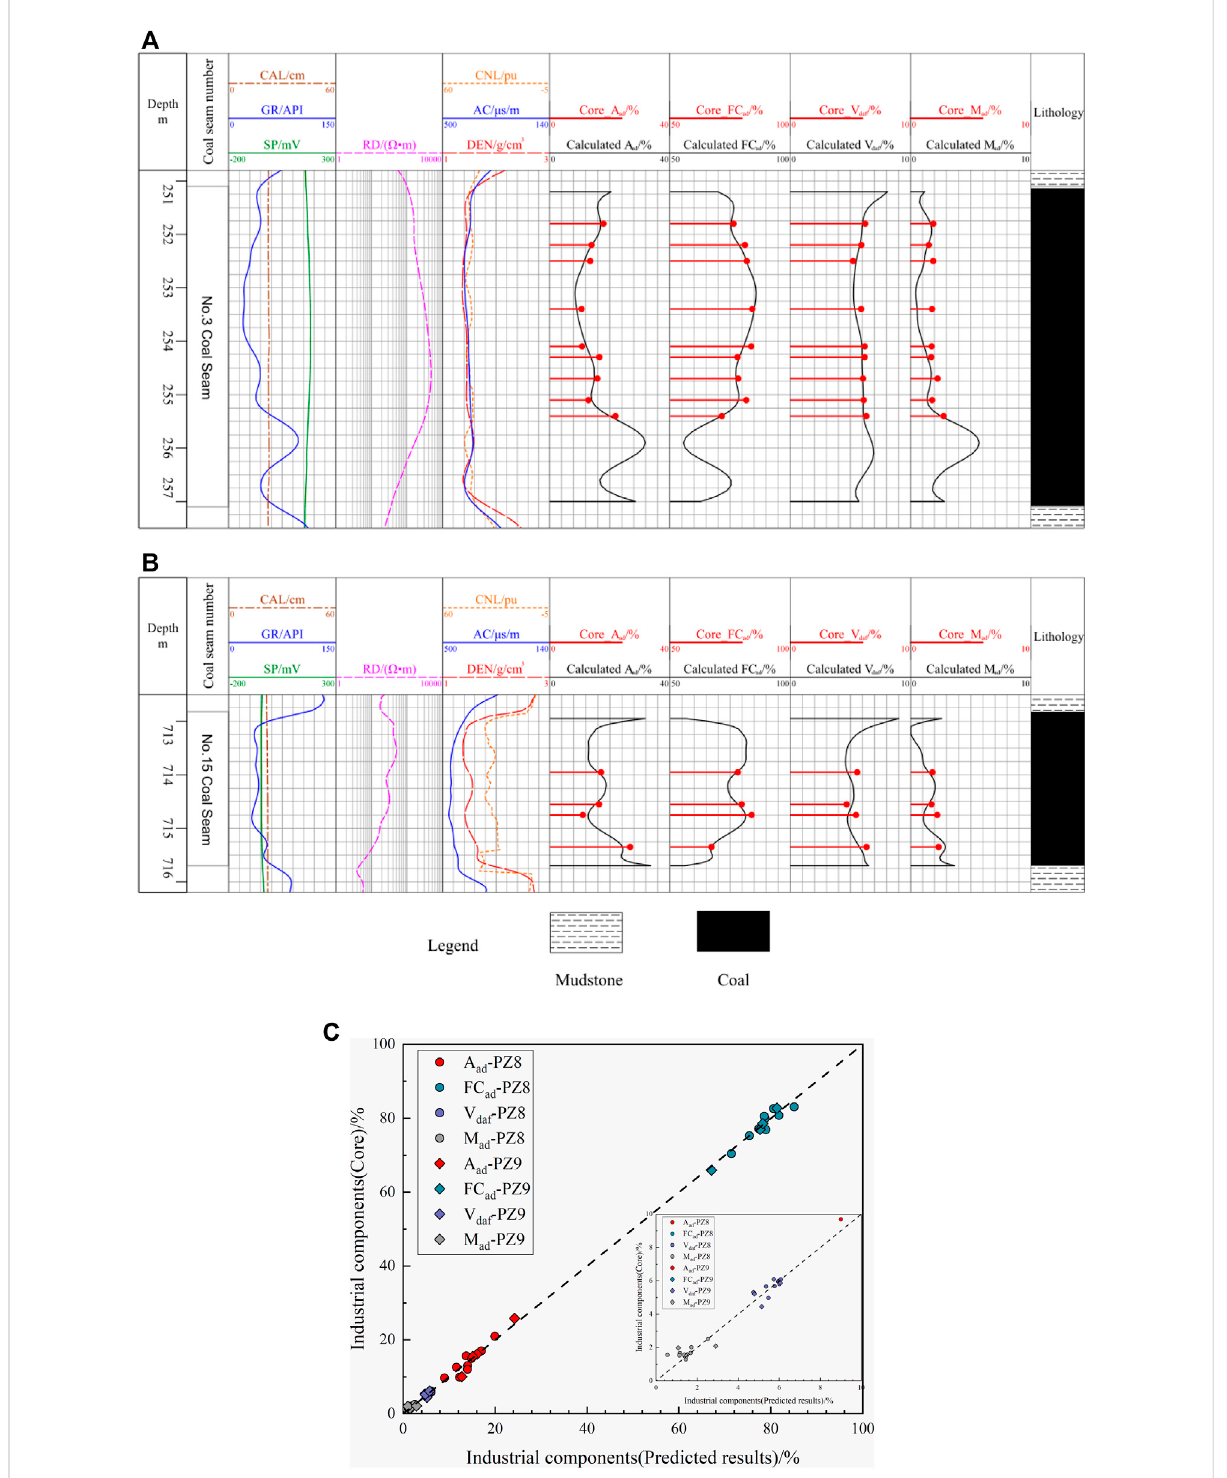
FIGURE 8 (A) Predicted industrial component contents of the new well PZ8 in the PZ block. (B) Predicted industrial component contents of the new well PZ9 in the PZ block. (C) Correlation between the predicted results and the experimental results for each industrial component in the new